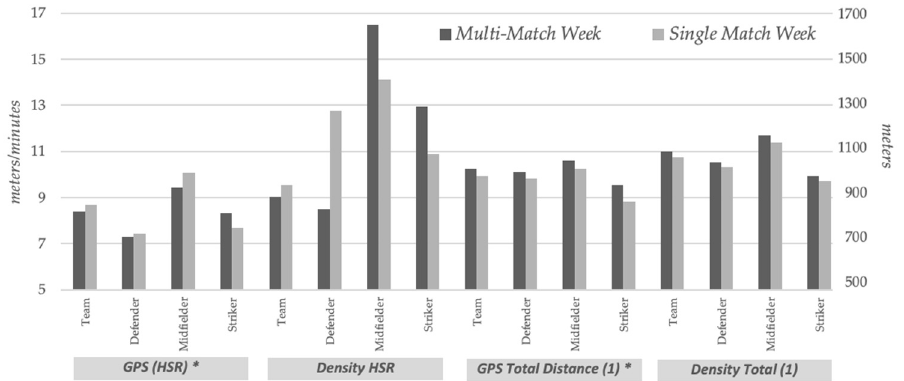
Figure 3. Match performance data in multi-match vs. single-match weeks in soccer players that completed more than 60 min in the game and according to player position. (1) For data representation, GPS total distance mean and density total mean were divided by 10. (*) GPS and GPS total distance are represented on the right axis. Table 2. Comparative assessment of muscle damage, wellbeing, body composition and match performance data in multi- match vs. single-match weeks in soccer players that completed more than 60 min in the game vs. those who played less.